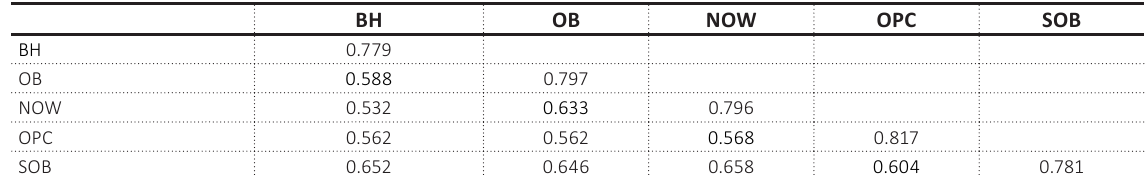
Table 2. Discriminant